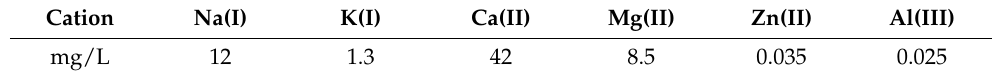
Table 3. Cations’ content of the simulated tap water sample without